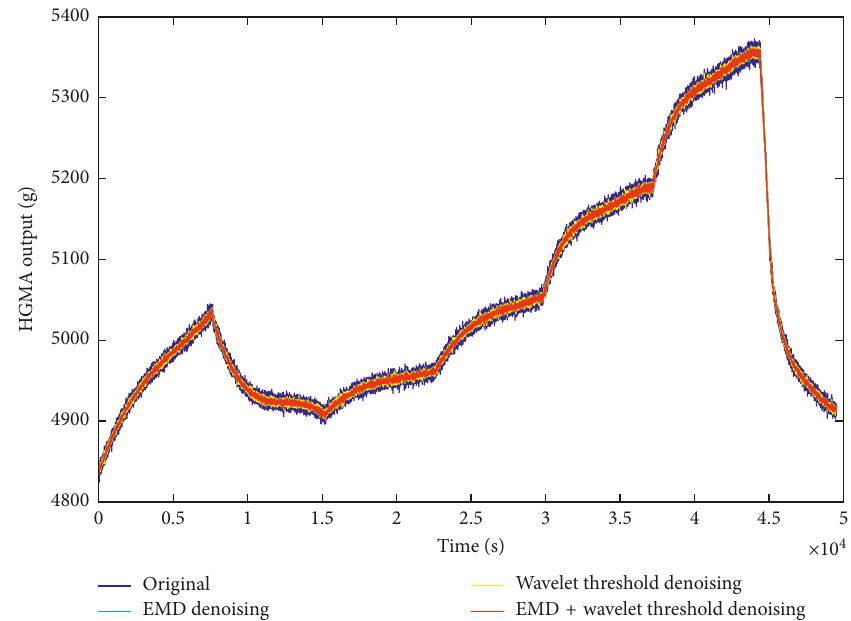
Figure 12: Contrast diagram of the noise reduction effect.